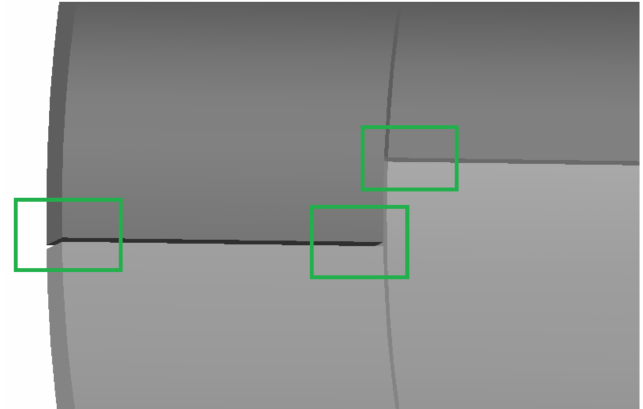
Figure 19. Shooting area for data acquisition.